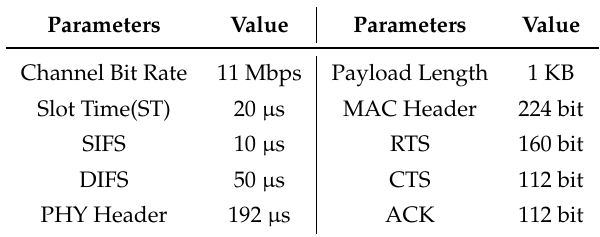
Table 3. PHY layer and MAC layer parameters used in